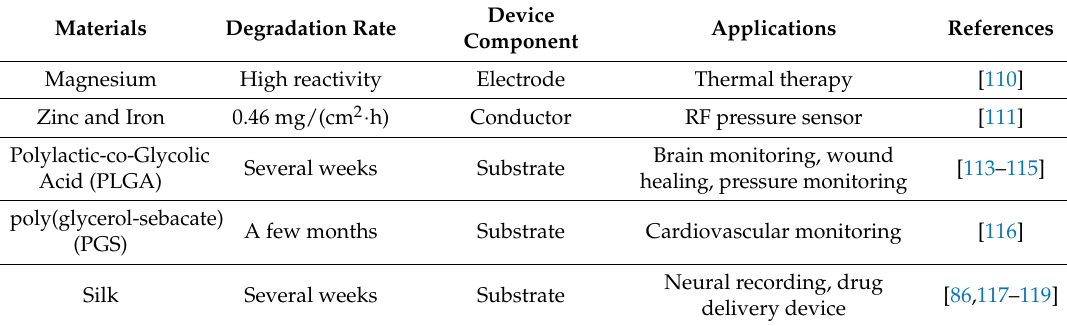
Table 3. Summary of biodegradable